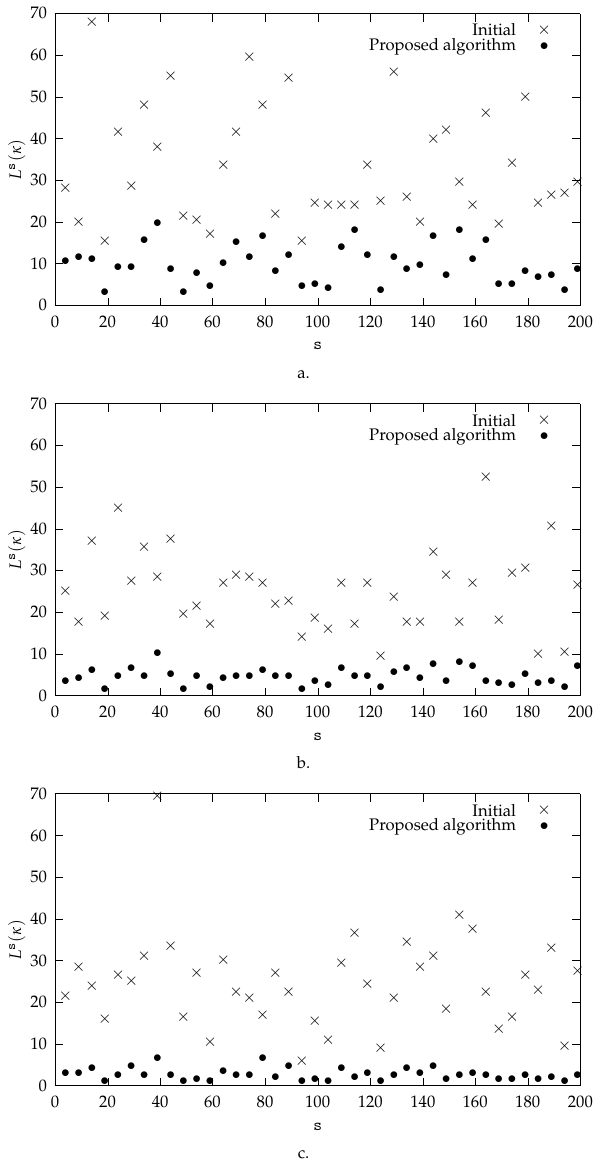
Figure 3. Cumulative traffic load of the most energy-consuming node L s ( κ ) before (Initial) and after applying the algorithm (Proposed Algorithm), for each sink node s and three different values of r c (a. r c = 0.3, b. r c = 0.4, and c. r c = 0.5).